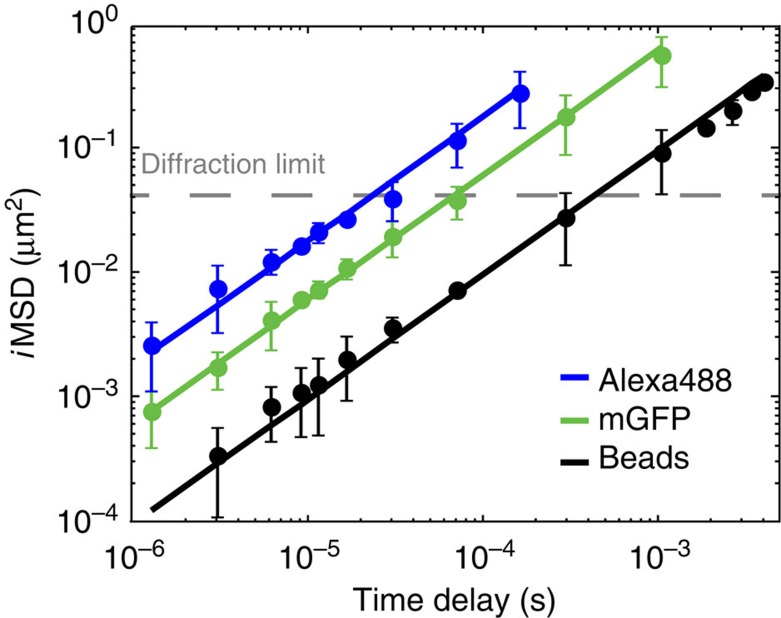
iMSD in dilute solution.Experimental iMSD values at the different timescales for differently sized molecules in dilute solution at 37 °C. Monomeric GFP (N=7 measurements, green dots) shows a linear behaviour in time, as expected for Brownian motion: fit by a free diffusion model (equation 13 in Supplementary Information) yields Dw=134±4 μm2 s−1 (, Hr=2.5 nm); Alexa488 (Dw=428±15 μm2 s−1, Hr=0.75 nm, , N=7 measurements; blue dots) and 30-nm-diameter fluorescent beads (Dw=22±0.5 μm2 s−1, , Hr=15 nm, N=7 measurements; black dots) are acquired under the same conditions. Data are mean values±s.d.